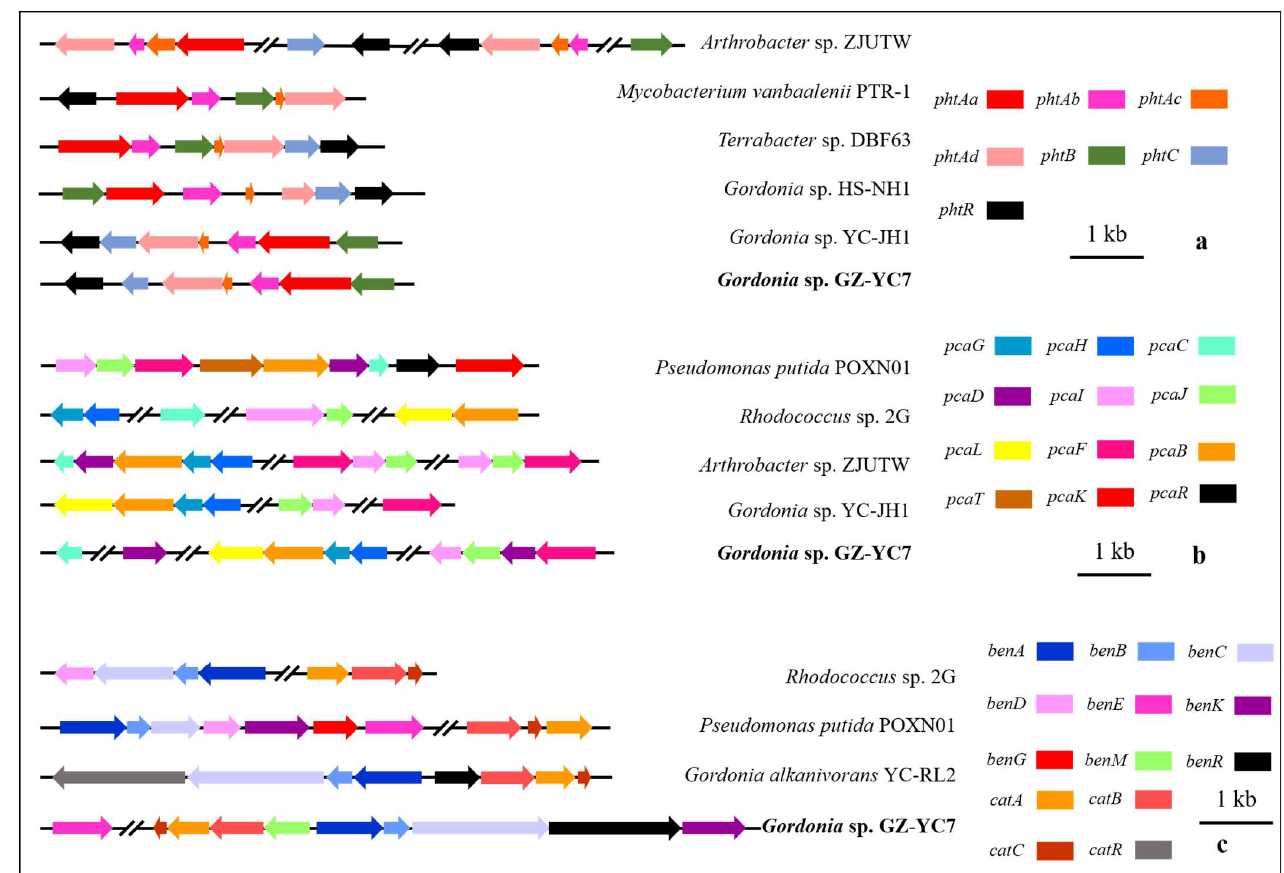
Figure 5. The comparative genomics analysis of the gene clusters pht ( a ), pca ( b ), ben ( c ), and cat ( c ).